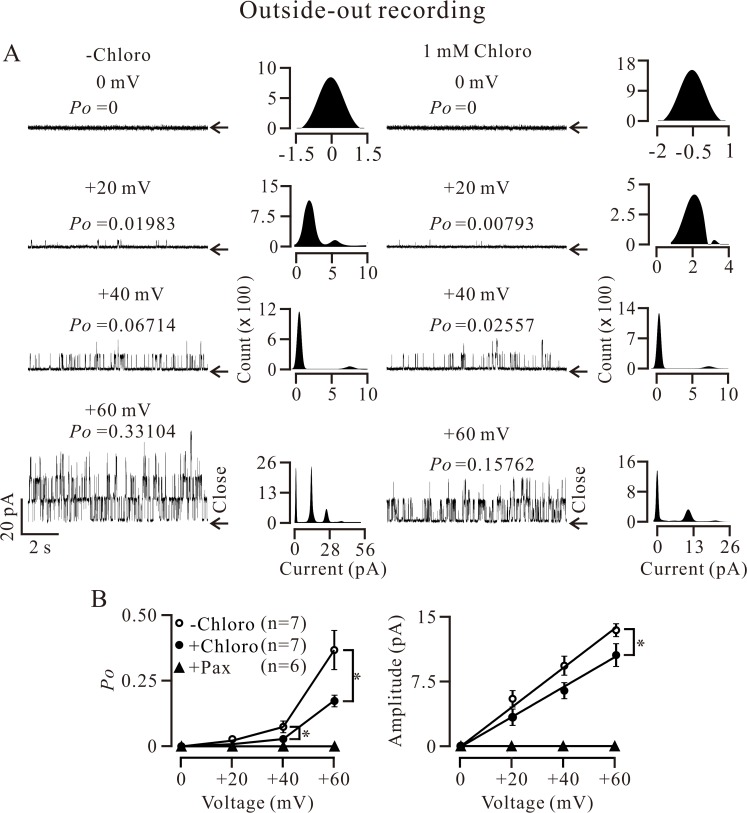
Extracellular chloro inhibits single BK currents.(A) Single channel currents were recorded using an outside-out approach. Following the addition of 1 mM chloro (from the extracellular side), single channel activities were partially inhibited. The Po values and amplitudes of single channel currents were calculated as described in Fig. 5. (B) The curves from 7 experiments show that the mean Po (at 40 and 60 mV) and amplitude (at 60 mV) were decreased. * denotes p < 0.05. These single channel currents were completely blocked by pax (n = 6), indicating these currents are BK currents. These results demonstrate that chloro partially inhibits BKs from the extracellular side.